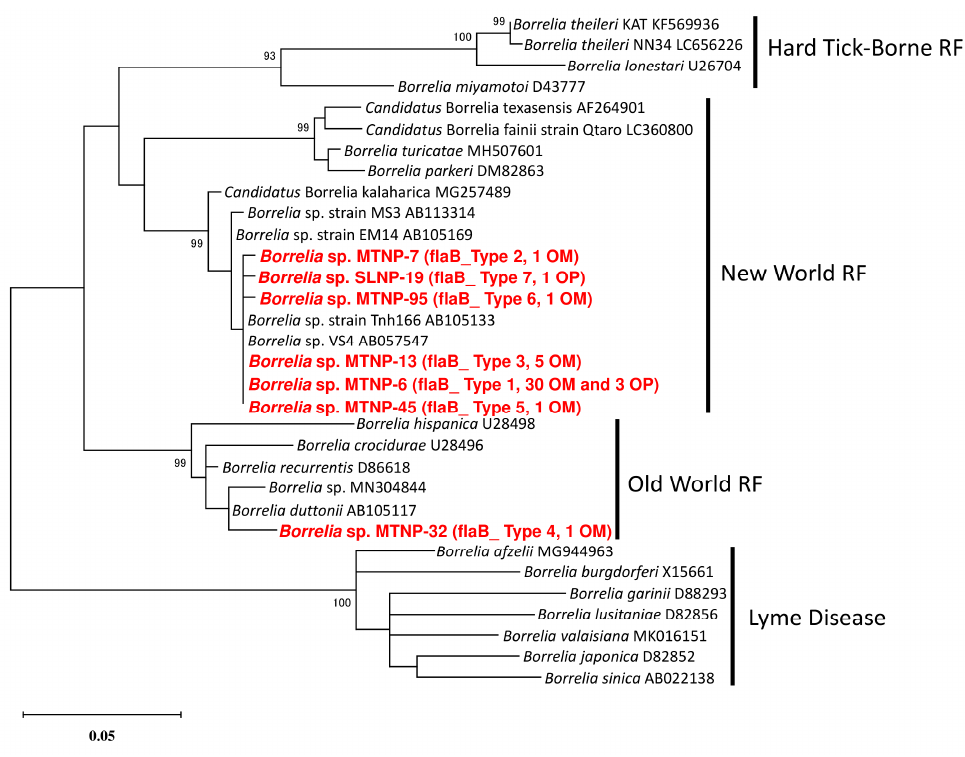
Table 3. Results of BLASTn search of 16S ribosomal DNA sequences.